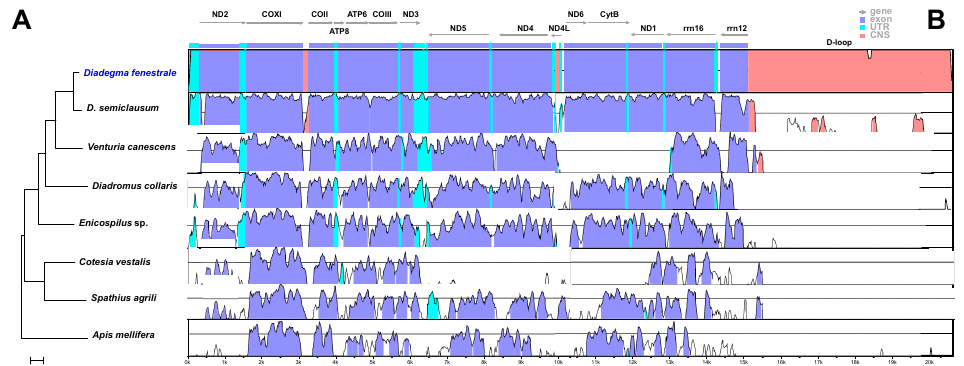
Figure 1. Comparison of entire mitochondrial genomes of Df and other Hymenoptera species. ( A ) Phylogeny inferred by using maximum likelihood with 1000 bootstrap repeats under MEGA11. The percentage of trees in which the associated taxa are clustered together is shown next to the branches. The tree is drawn to scale, with branch lengths measured in the number of substitutions per site. ( B ) Schematic diagram of genes and their flanking regions showing sequence diversity in mVISTA. Partial mitochondrial genome sequences of parasitoids and additional Hymenoptera species were realigned for primer design with those of the target species, Df and Ds (Figure 2A). Df, Diadegma fenestrale ; Ds, Diadegma semiclausum ; UTR, untranslated region; D-loop, displacement loop. D. semiclausum EU871947, Venturia canescens FJ478176, Diadromus collaris JX131613, Enicospilus sp. FJ478177, Cotesia vestalis FJ154897, Spathius agrili FJ387020, and Apis mellifera KY926884 sequence information was downloaded from GenBank.